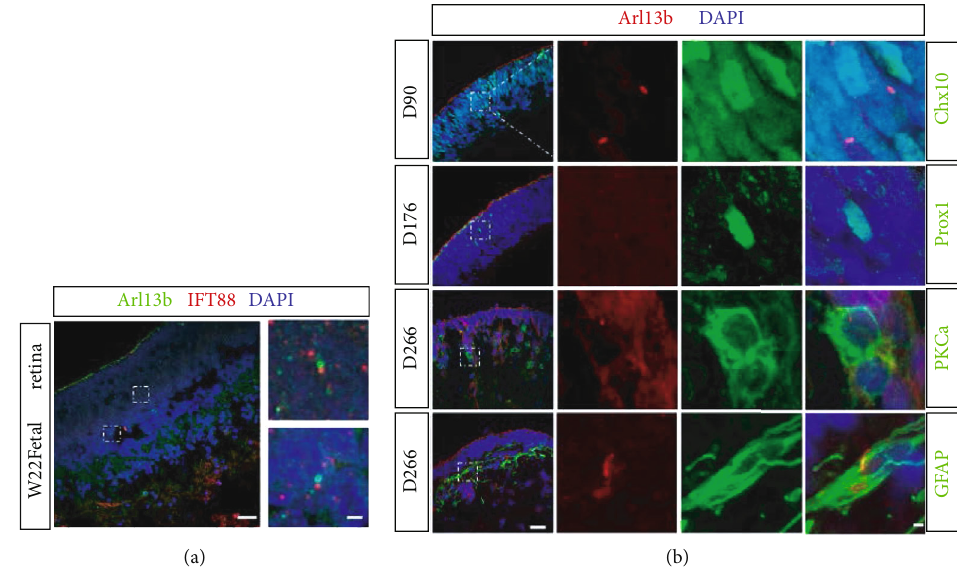
Figure 3: Primary cilia are present in Chx10-positive, GFAP-positive, and PKC α -positive retinal cells. (a) Photomicrograph of primary cilia in sections from human fetal retina (week 22, n = 1 ). Arl13b (in green) and IFT88 (in red) antibodies were used as cilia markers. (b) Representative confocal images of retinal organoid sections stained with cell and primary cilia markers (Arl13b in red). Chx10: marker for retinal progenitor cells; Prox1: marker for horizontal cells: PKC α : marker for rod-bipolar cells; and GFAP: marker for astrocytes. All cell markers are labeled in green. Nuclei are stained by DAPI (blue). Scale bar: 10 μ m; magni fi ed, 1 μ